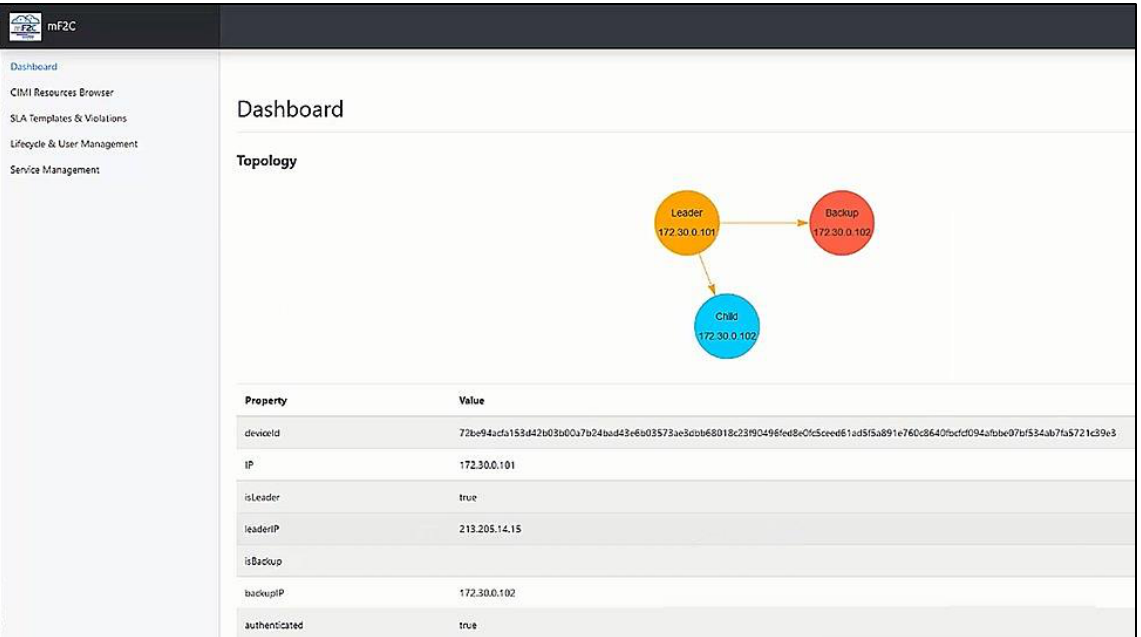
Figure 4. Dashboard and system